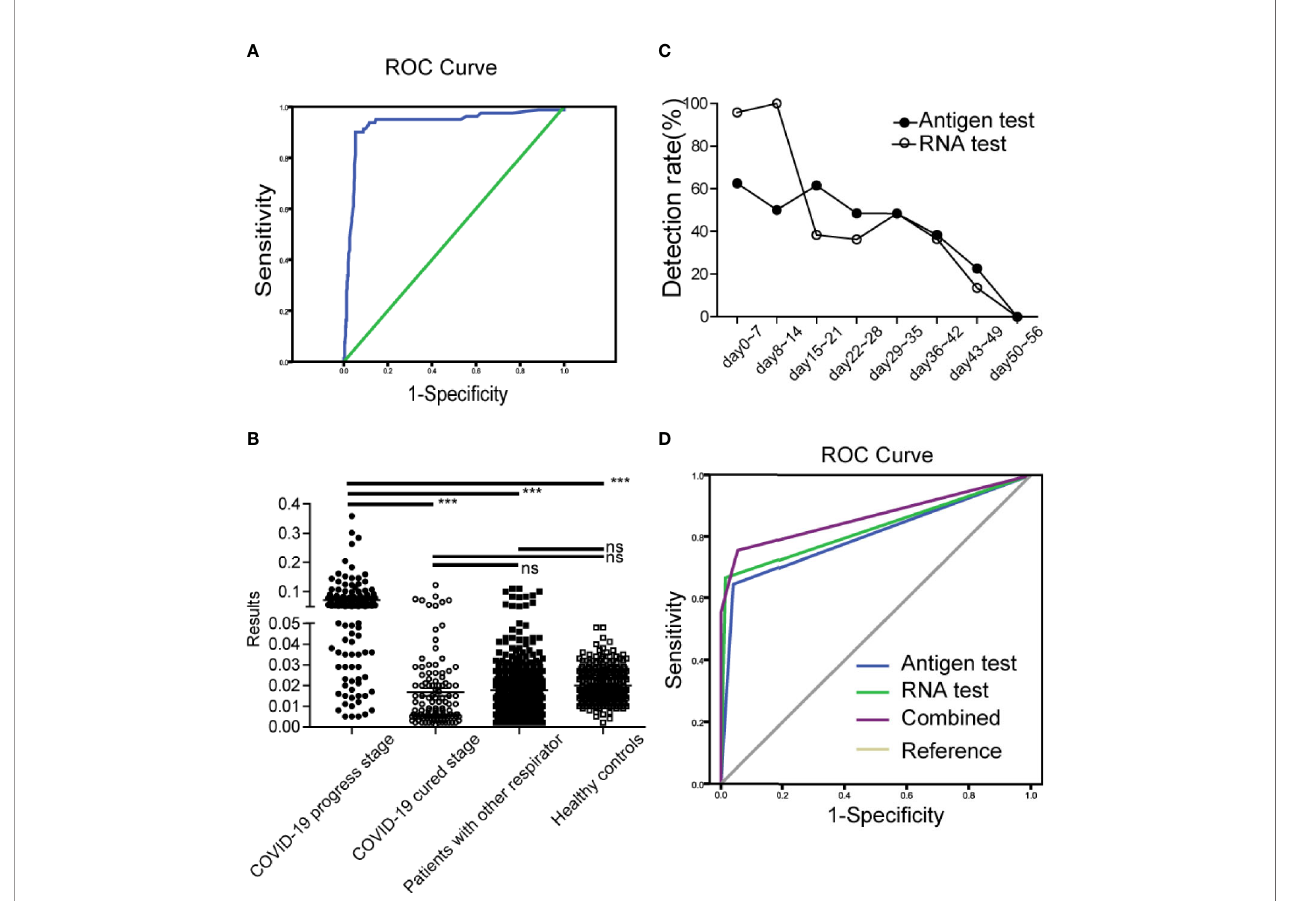
FIGURE 3 | Clinical application and evaluation of antigen strips (A) . ROC curve for the cutoff determine of antigen strips (B) . The results of antigen strips in COVID-19 cases (progress stage, ● ; cured stage, ○ ), patients with other respiratory diseases ( ■ ), and healthy controls ( □ ). ***p < 0.001; ns, nonsense (C) . The antigen detection rate at different time of development of COVID-19. Antigen test ( ● ), RNA test ( ○ ) (D) . Diagnosis value of antigen strips, RNA detection and combined evaluation.